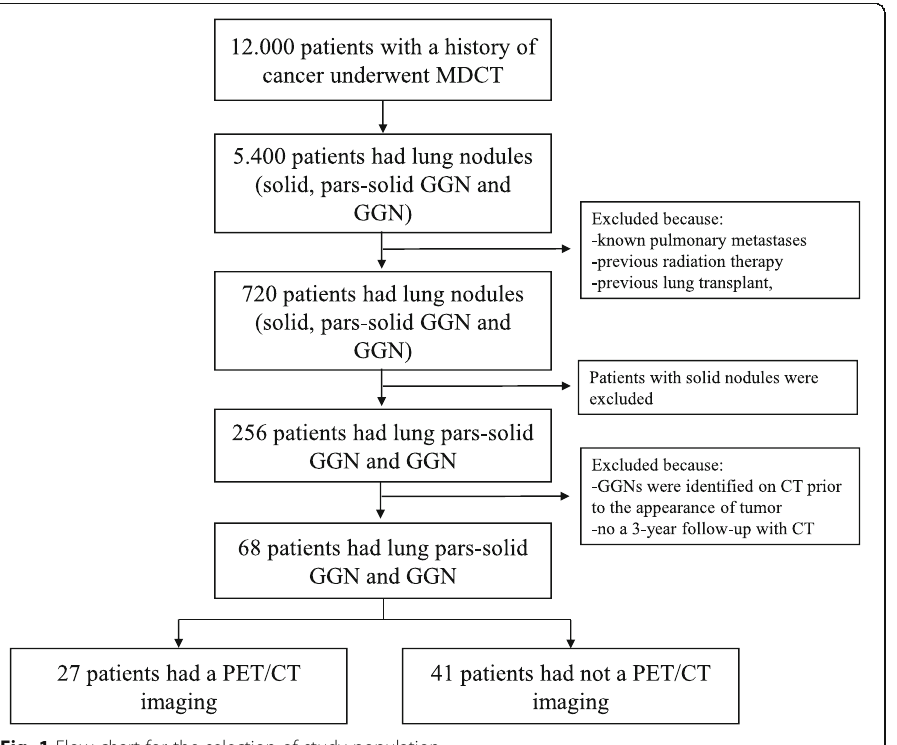
Fig. 1 Flow-chart for the selection of study